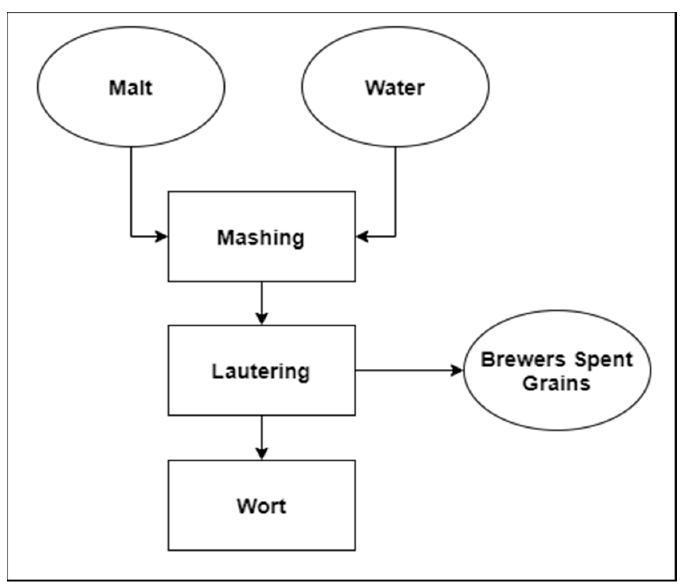
Figure 1. Diagram of beer wort production with an emphasis on the main solid by-product.